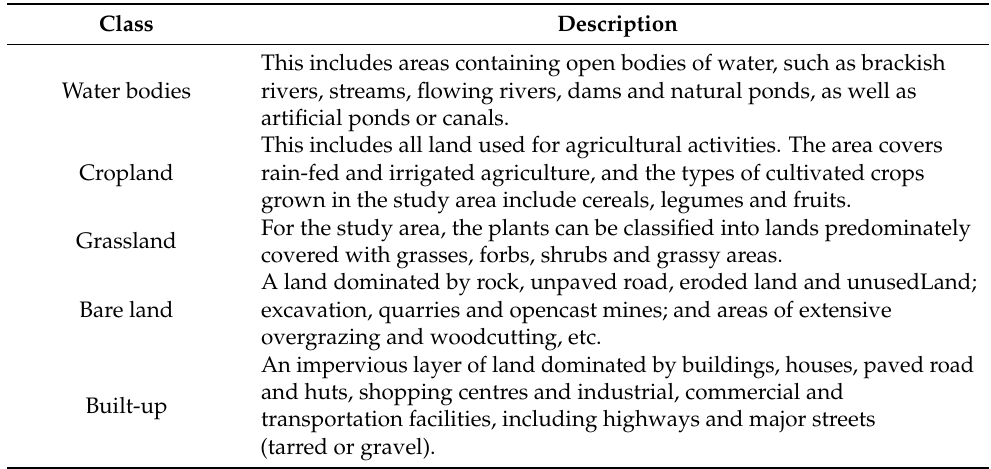
Table 2. Description of different land cover classes in the study area. Class Description Water bodies